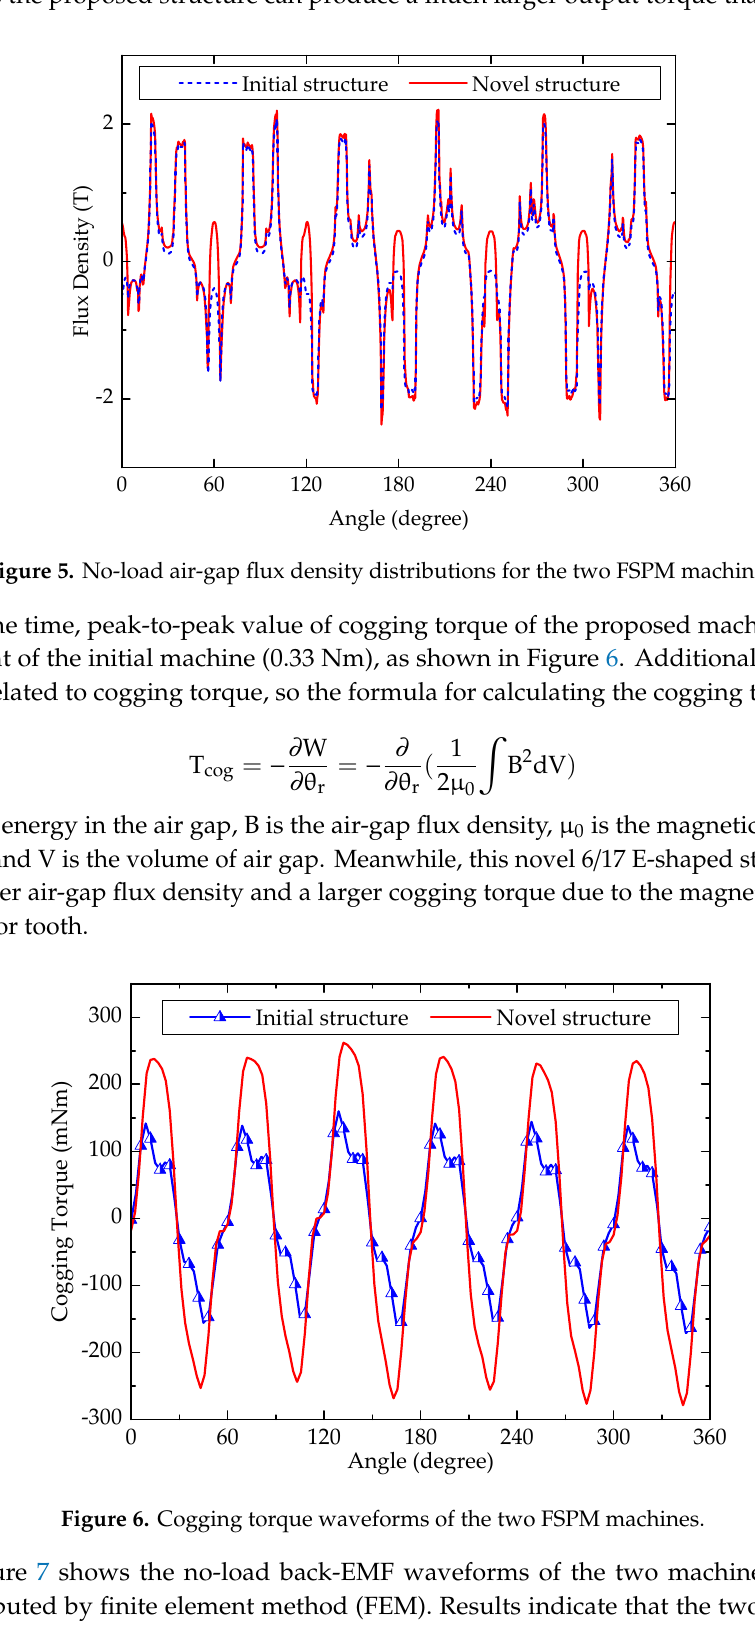
Figure 4. No ‐ load magnetic flux distributions of two FSPM machines: ( a ) conventional 6/17 FSPM machine; ( b ) proposed 6/17 FSPM machine.